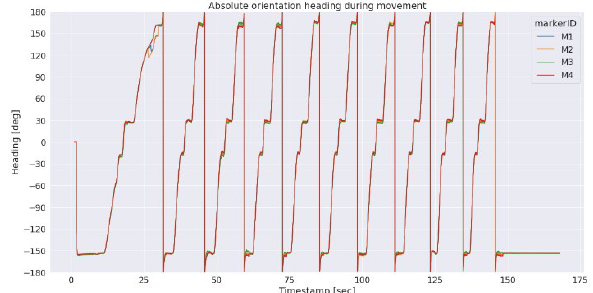
Figure 11. Heading of absolute orientation during 10 laps